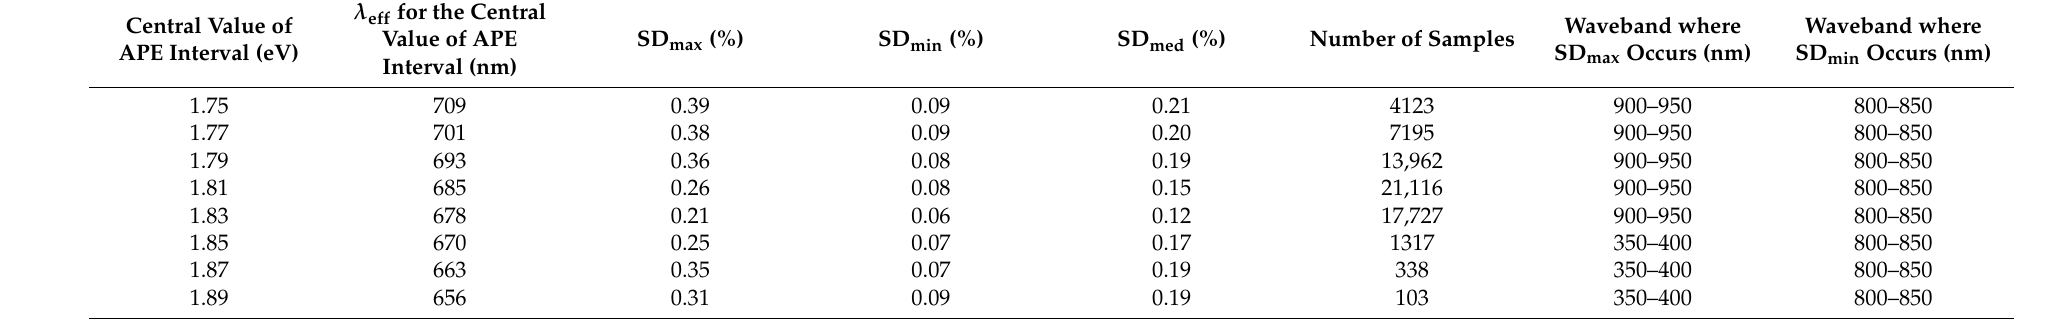
Table 1. Maximum, minimum, and mean values of SD of R c for every 50-nm band according to their APE interval and corresponding effective wavelength, λ eff . Central Value